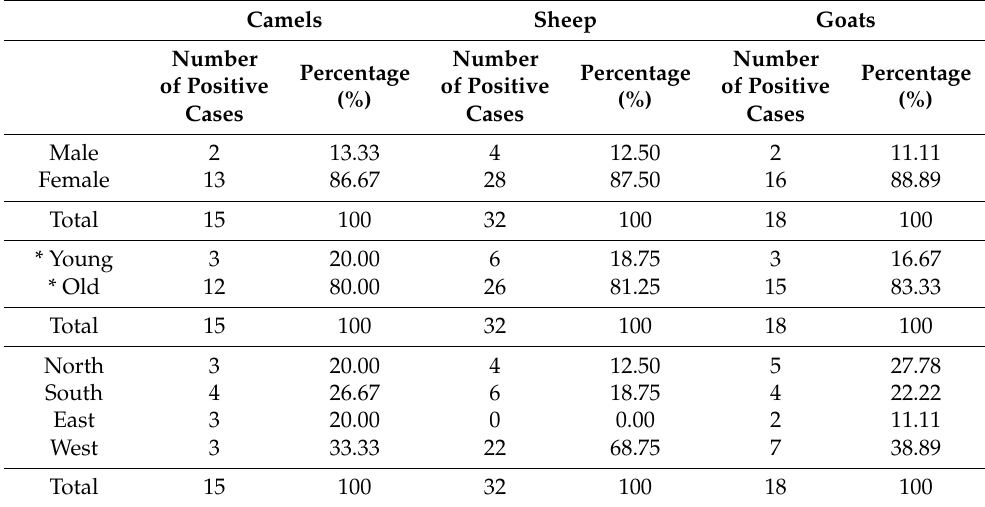
Table 4. Distribution of seroprevalence of brucellosis in camels, sheep, and goats.